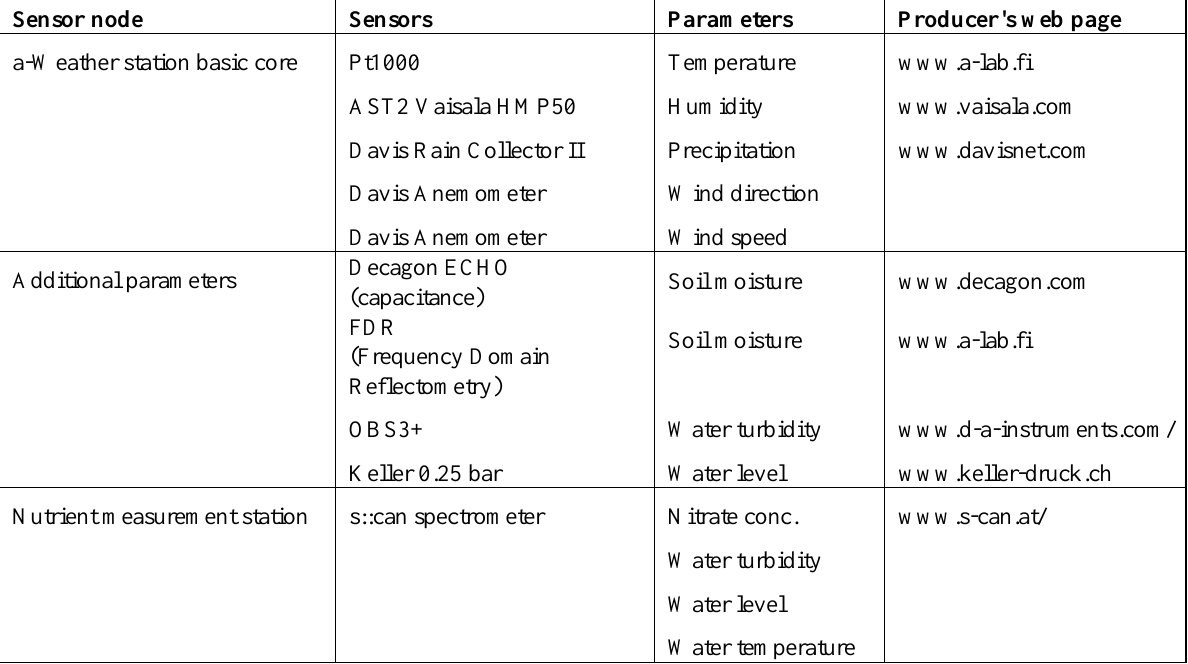
Table 1. The sensors used and the parameters measured in the SoilWeather